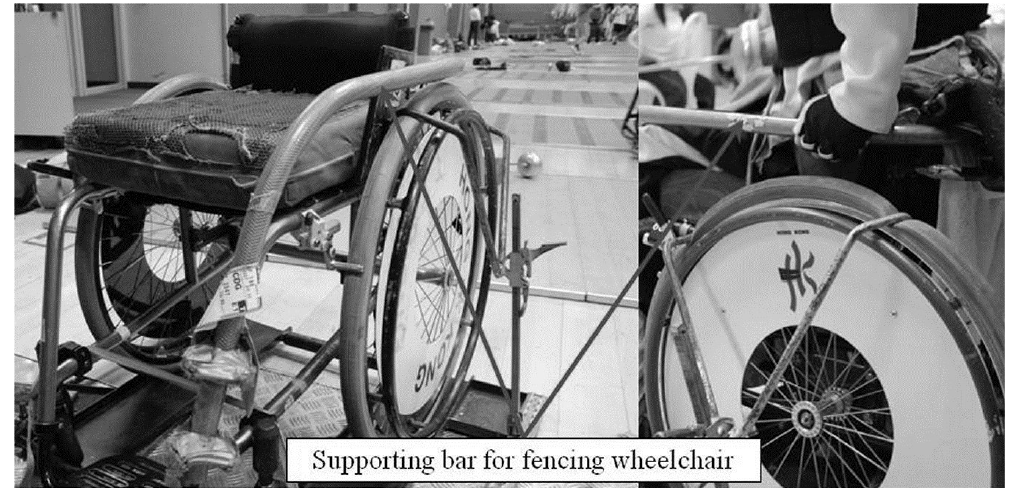
A fencing wheelchair equipped with a supporting